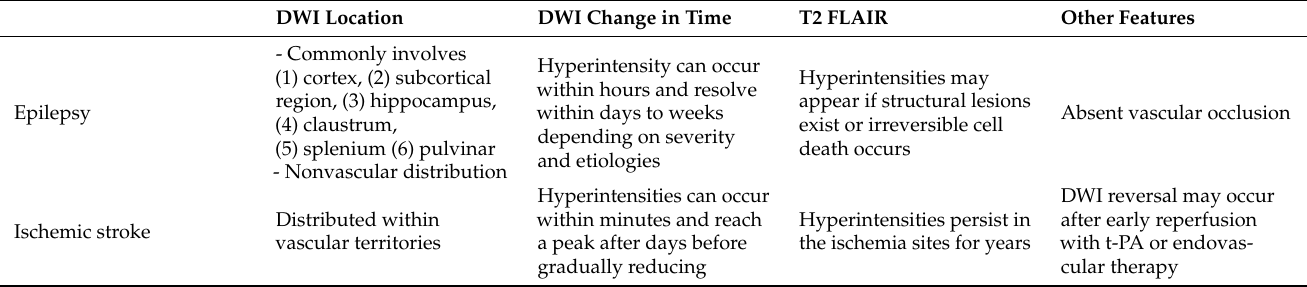
Table 2. Summary of common neurological disorders associated with DWI